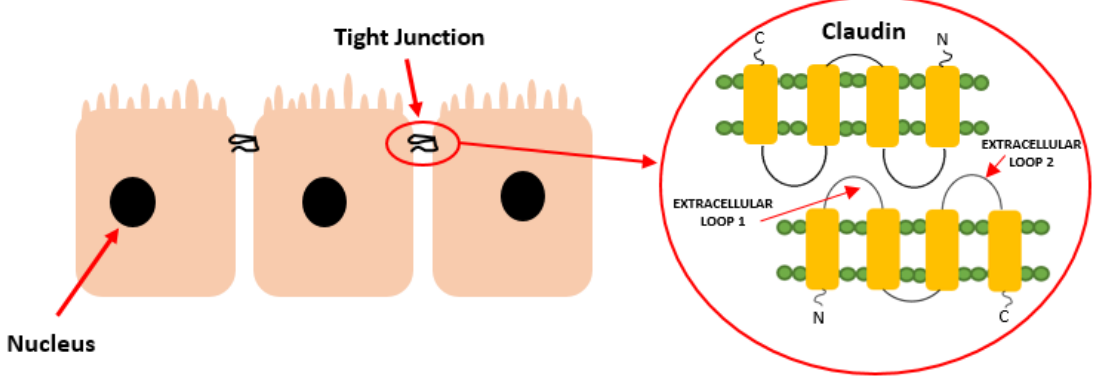
Figure 1. Structure of claudins, as a part of a tight junction.